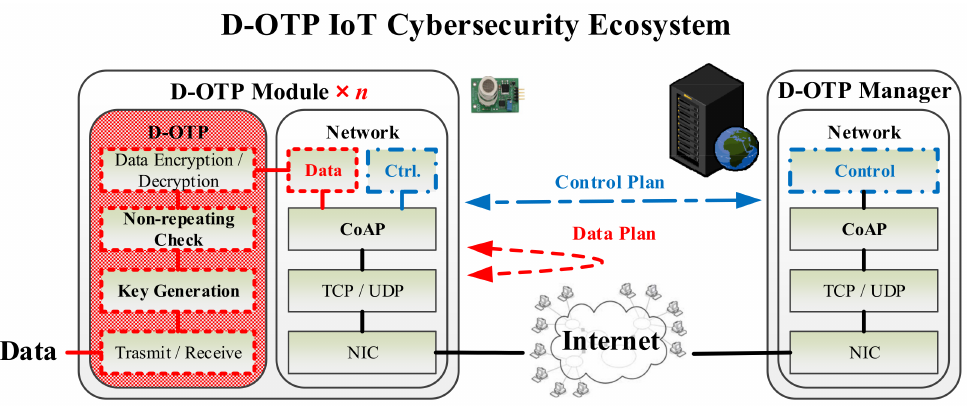
Figure 3. A D-OTP deployment scheme for building a secure IoT transmission